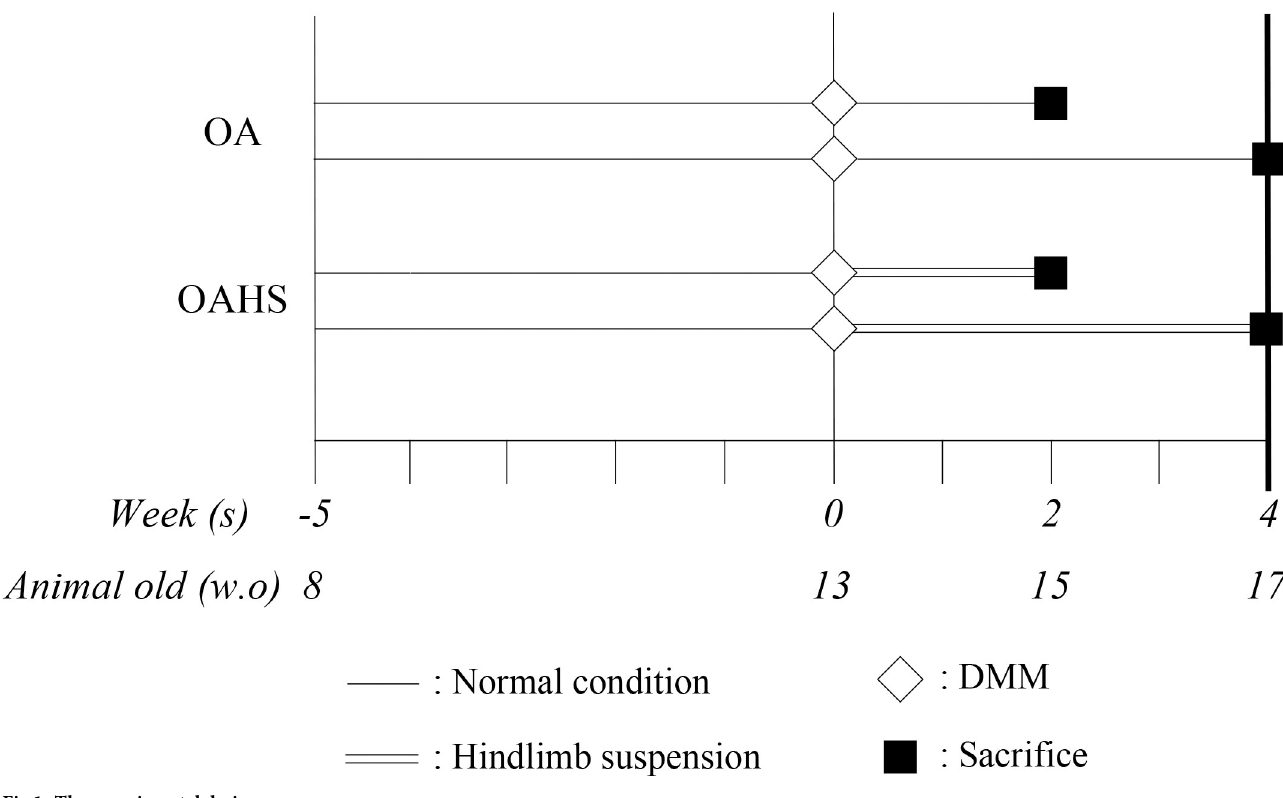
Fig 1. The experimental